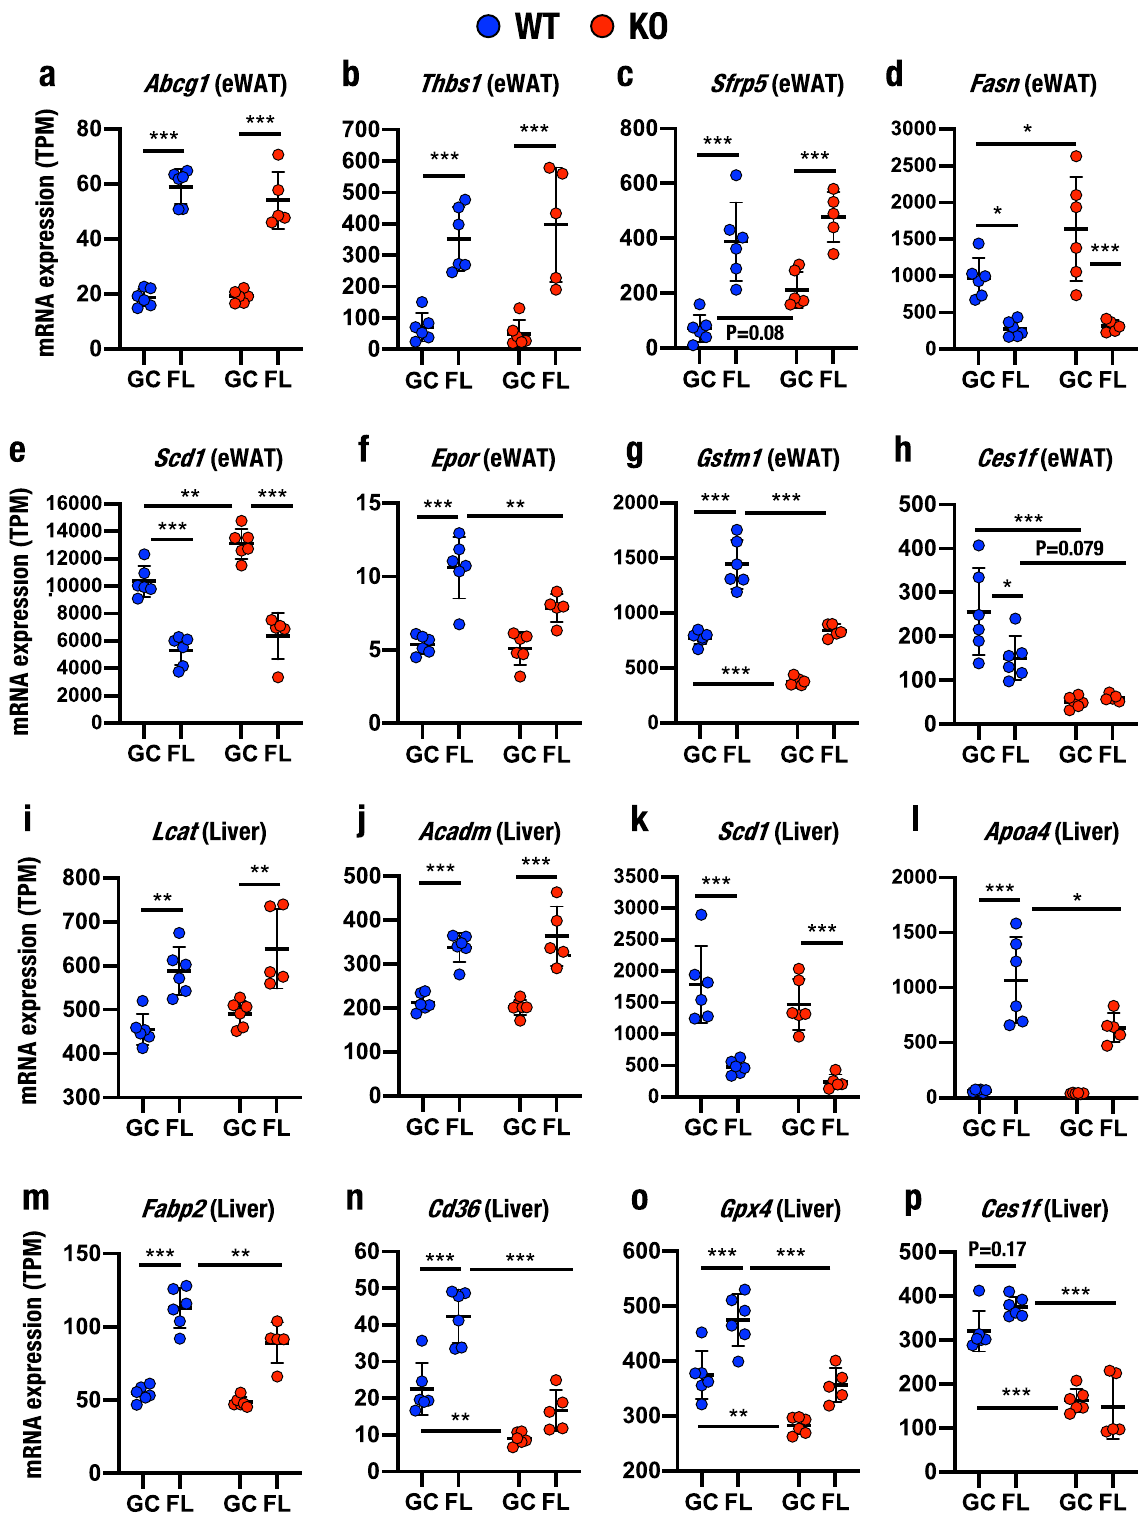
Fig. 7 Differentially expressed genes identi fi ed in the eWAT and liver after space fl ight. a – p Expression levels of representative differentially expressed genes in eWAT ( a – h ) and liver ( i – p ) determined using RNA-seq analyses. Expression levels (TPM) of Abcg1 ( a ), Thbs1 ( b ), Sfrp5 ( c ), Fasn ( d ), Scd1 ( e , k ), Epor ( f ), Gstm1 ( g ), Ces1f ( h , p ), Lcat ( i ), Acadm ( j ), Apoa4 ( l ), Fabp2 ( m ), Cd36 ( n ) and Gpx4 ( o ) are presented as the means ± SD. Statistical analyses were performed using ANOVA followed by Tukey ’ s post hoc test. * P < 0.05, ** P < 0.01 and *** P <